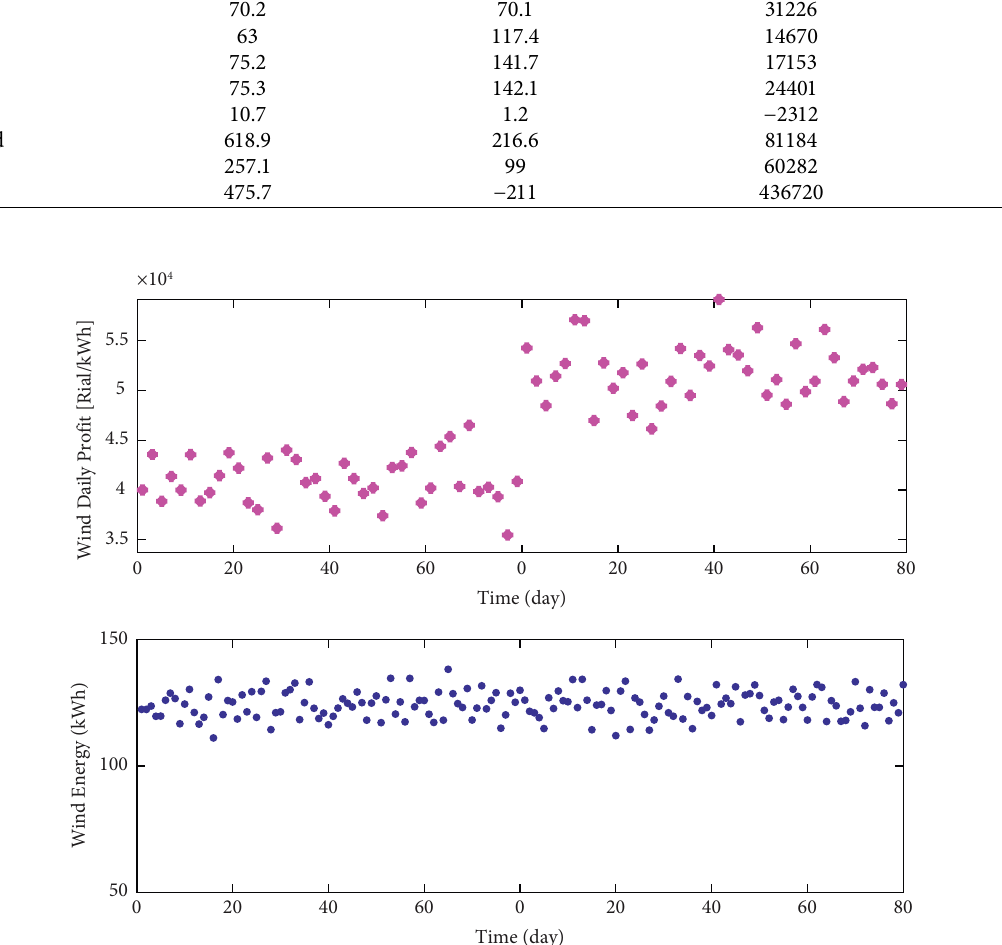
Figure 4: Average daily proft and output power of wind